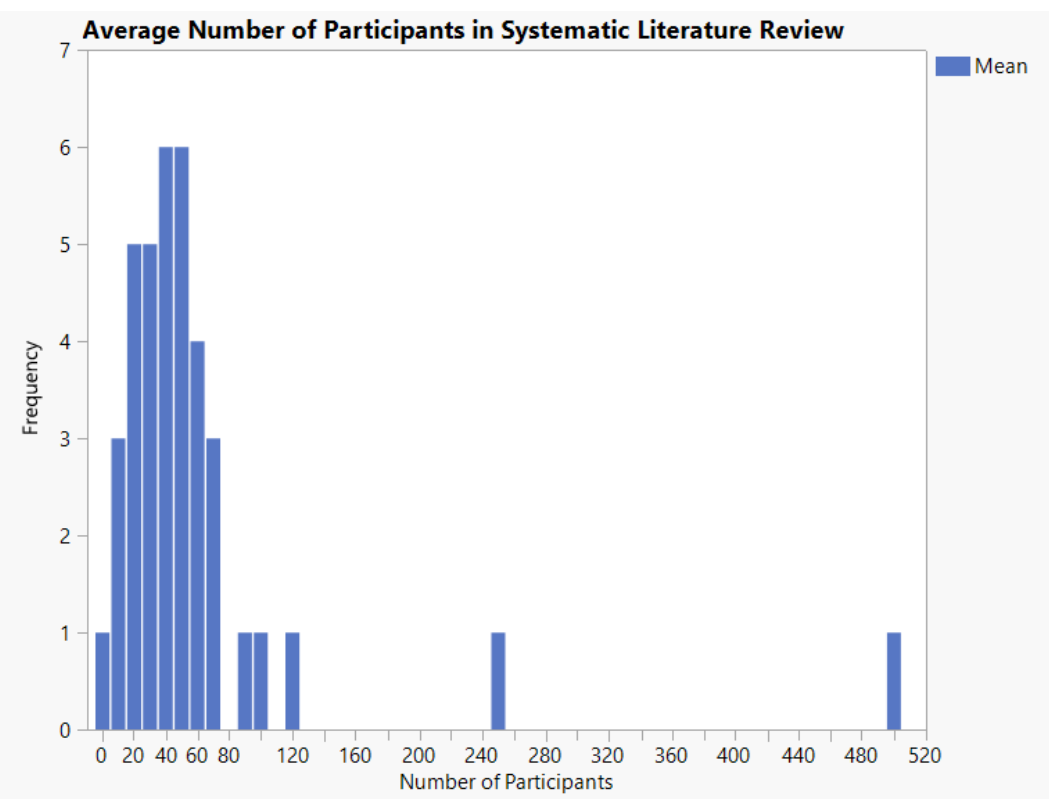
Figure 3. Number of participants across the 38 studies related to AFEA, beverages, and/or packaging.